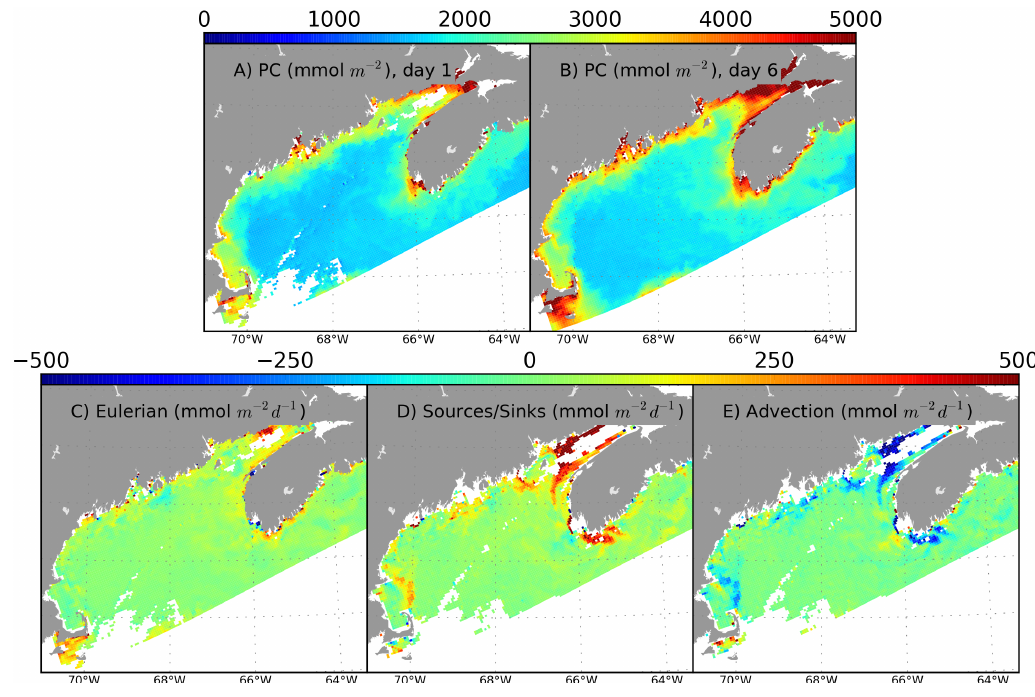
Fig. 2. Panels (a) and (b) show two satellite images from 1 and 6 January 2005, of euphotic depth-integrated Chl- a scaled to PC using a fixed C:Chl ratio of 60. Panel (c) is the (Eulerian) difference calculated by subtracting panel (a) from panel (b) , ∂ PC /∂t . Panel (d) shows the difference between the start and end values of PC along water parcel trajectories, i.e. ∂ PC /∂t + u × ∇ ( PC ) . These trajectories are computed by seeding particles uniformly in the model flow field and advecting them with surface velocities for the time between the satellite images. They thus represent the source/sink of PC in the moving frame, i.e. NCP e . Panel (e) represents the advective component of the change. It is that part of (d) that remains after the Eulerian change shown in (c) is subtracted, i.e. u × ∇ ( PC ) , plotted with a negative sign.